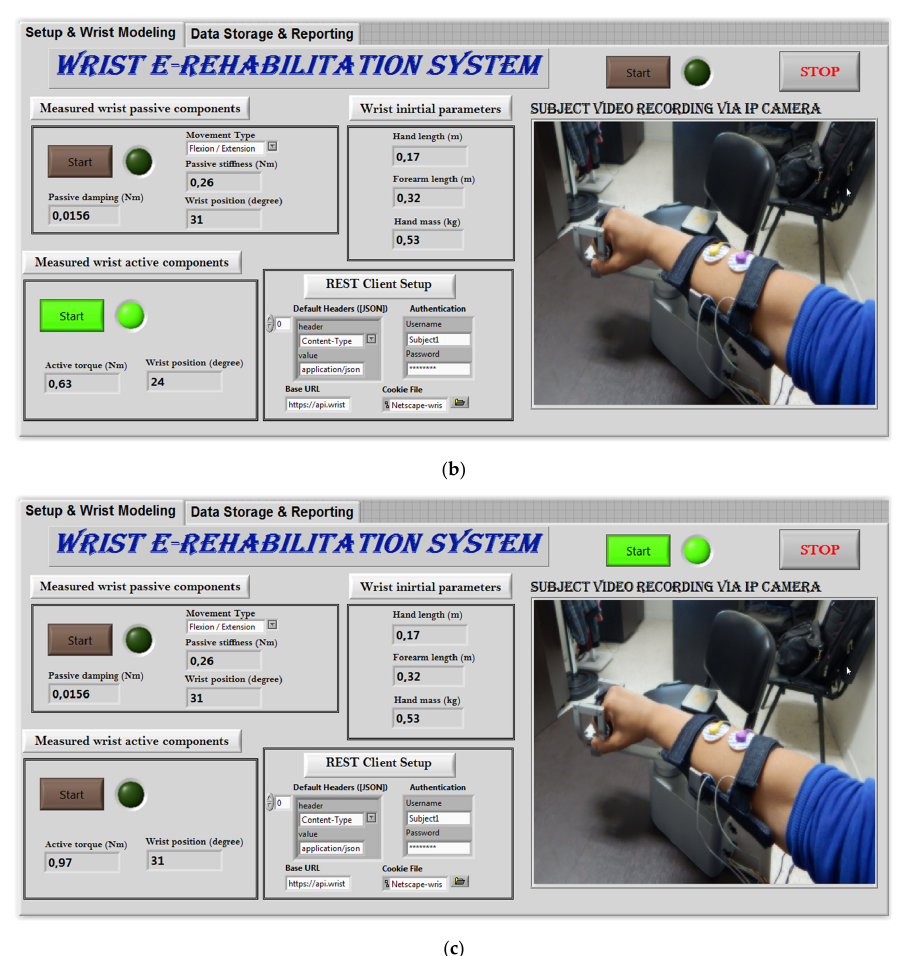
Figure 14. Setup sequences: ( a ) measuring passive wrist components; ( b ) measuring wrist active components; ( c ) continuous exercises.